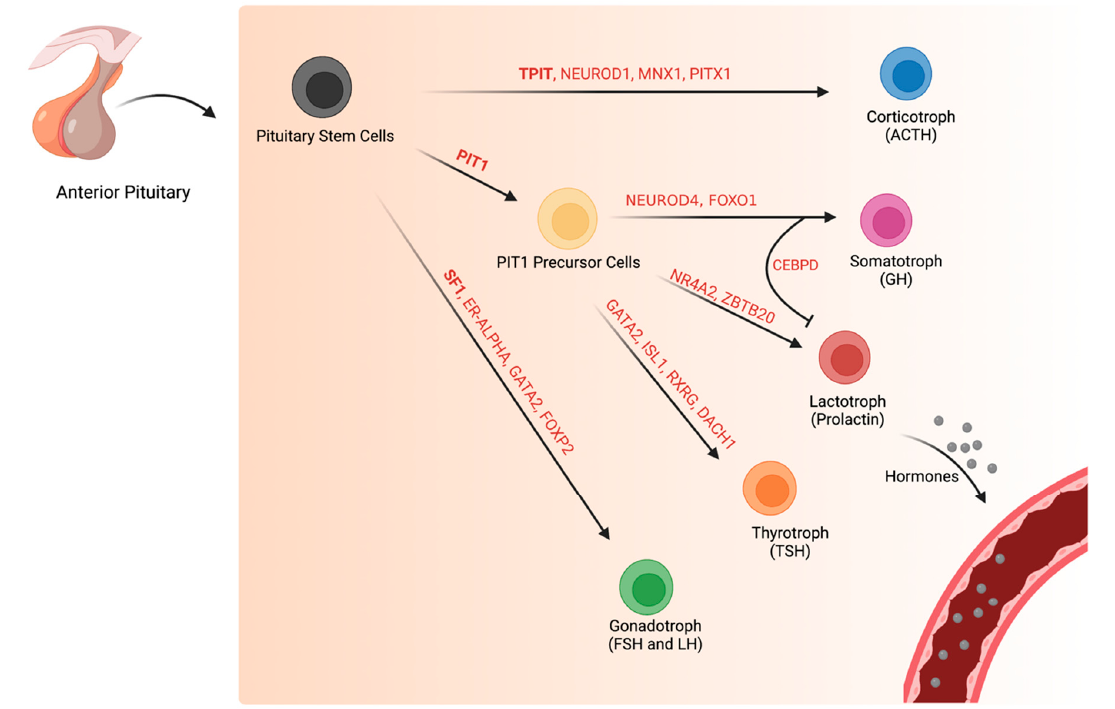
Figure 1. Specific transcription factors drive normal pituitary cell differentiation during development. Pituitary stem cells differentiate into five specialized, endocrine hormone-producing cell types: corticotrophs (ACTH), somatotrophs (GH), lactotrophs (prolactin), thyrotroph (TSH), and gonadotrophs (LH and FSH). Pituitary cell differentiation requires a complex cascade of transcription factors, many of which are still in the process of being identified. Only select transcription factors are highlighted in this diagram.